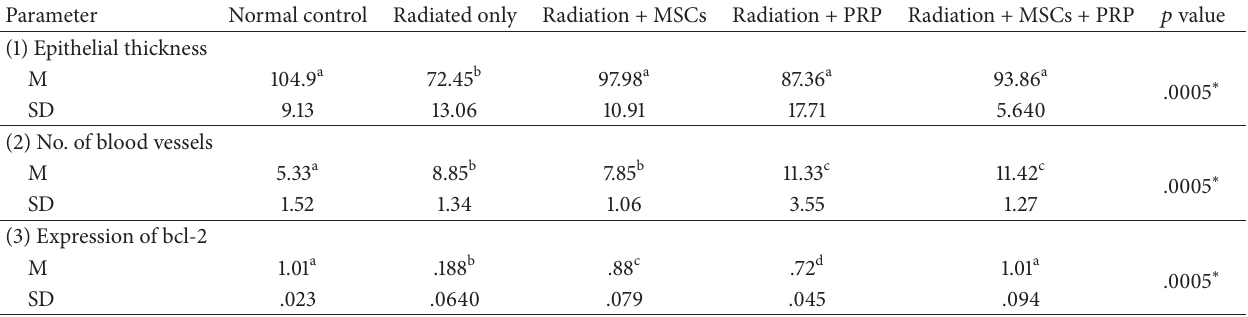
Table 2: Comparison of (epithelial thickness, number of blood vessels, and expression of bcl-2) between control group and different experimental groups at 7 days after